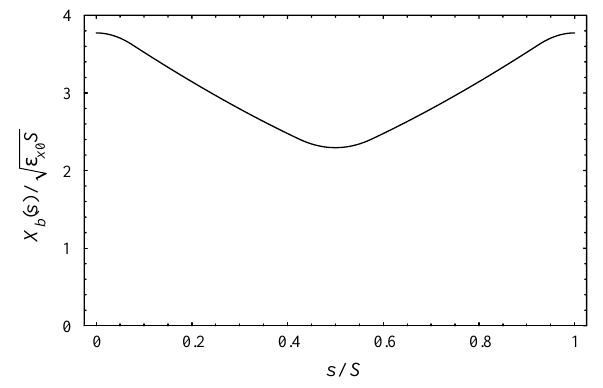
p e x 0 S versus s (cid:3) S obtained FIG. 5. Illustrative plot of X b (cid:1) s (cid:2)(cid:3) numerically from Eq. (61) for a matched beam with moderate space-charge intensity propagating through the periodic step- function lattice in Fig. 4. Here, the dimensionless system param- p e x 0 S (cid:1) eters correspond to ˆ k x S 2 (cid:1) 14.92 , h (cid:1) 0.3 , and K b S (cid:3) 5 , with vacuum phase advance s vac (cid:1) 60 ± and depressed phase advance s (cid:1) 3.4 ±